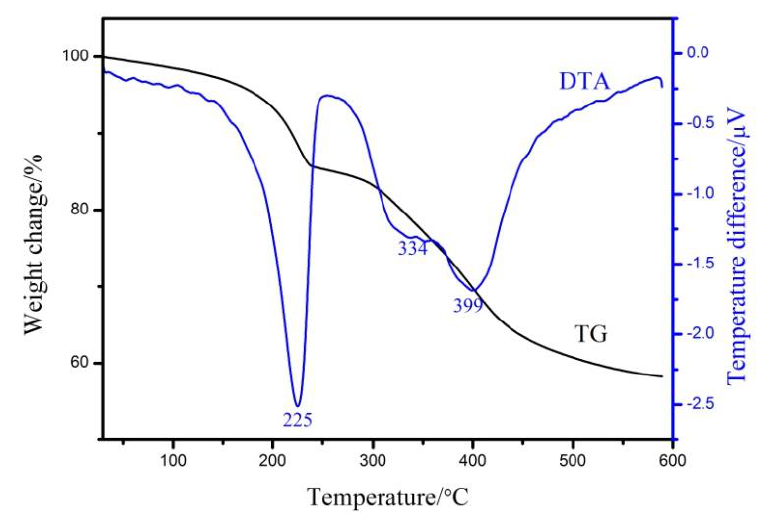
Figure 5. TG-DTA curve of Mg 2 Al-CO 3 LDHs prepared by basic magnesium carbonate as carbon source.